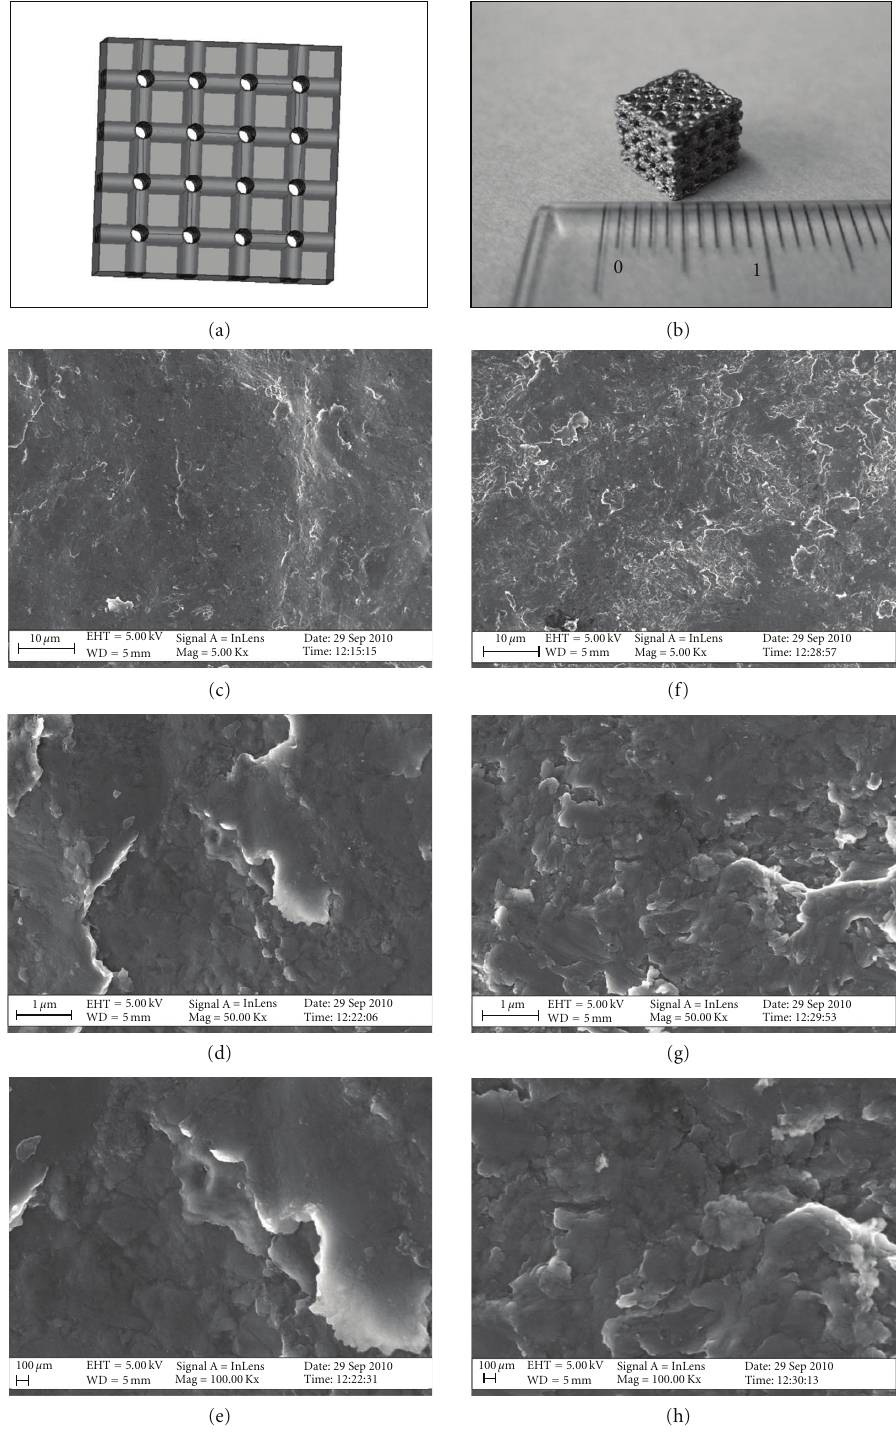
Figure 1: (a) CAD model used for the EBM-fabrication of cp-Ti and Ti6Al4V sca ff olds. (b) A photograph showing the sca ff olds used in the present study. (c–h) SEM images showing the surface topography of cp-Ti (c–e) and Ti6Al4V (f–h) sca ff olds at increasing magnifications; scale bar = 10 μ m, 1 μ m, and 100nm,